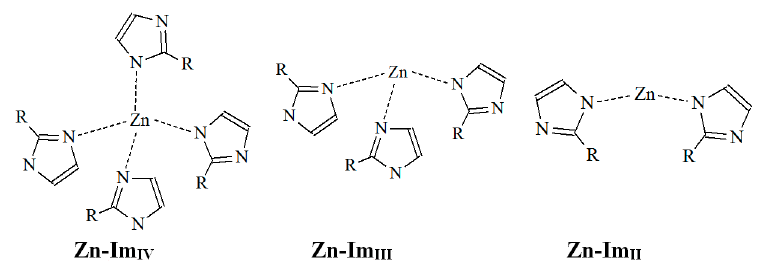
Figure 2. ( A ) The effect of ZIF-8 particle size on microporosity (V µ /V Σ ) and the ratio of I 2245 /I 2253 . (Internal: DRIFT spectra of CDCl 3 adsorbed on ZIF-8). ( B ) The effect of Co content in the framework of Zn/Co-ZIFs and on the ratio of band intensities I 252 /I 295 (Internal: DR–UV–vis spectra of ZIF-8(Zn)—1; Zn/Co-ZIF(75/25)—2; Zn/Co-ZIF(50/50)—3; Zn/Co-ZIF(25/75)—4; and ZIF-67(Co)—5). ( C ) The correlation between data of DR–UV–vis (I 300 /I 360 ), DRIFT-CDCl 3 spectroscopy (I 2242 ), and D SEM /D X-ray . ( D ) The correlation between the intensity of the band at 2242 cm − 1 observed in the IR spectra of CDCl 3 adsorbed on MAF-6 and the ratio of I 300 /I 360 observed in DR–UV–vis spectra of MAF-6